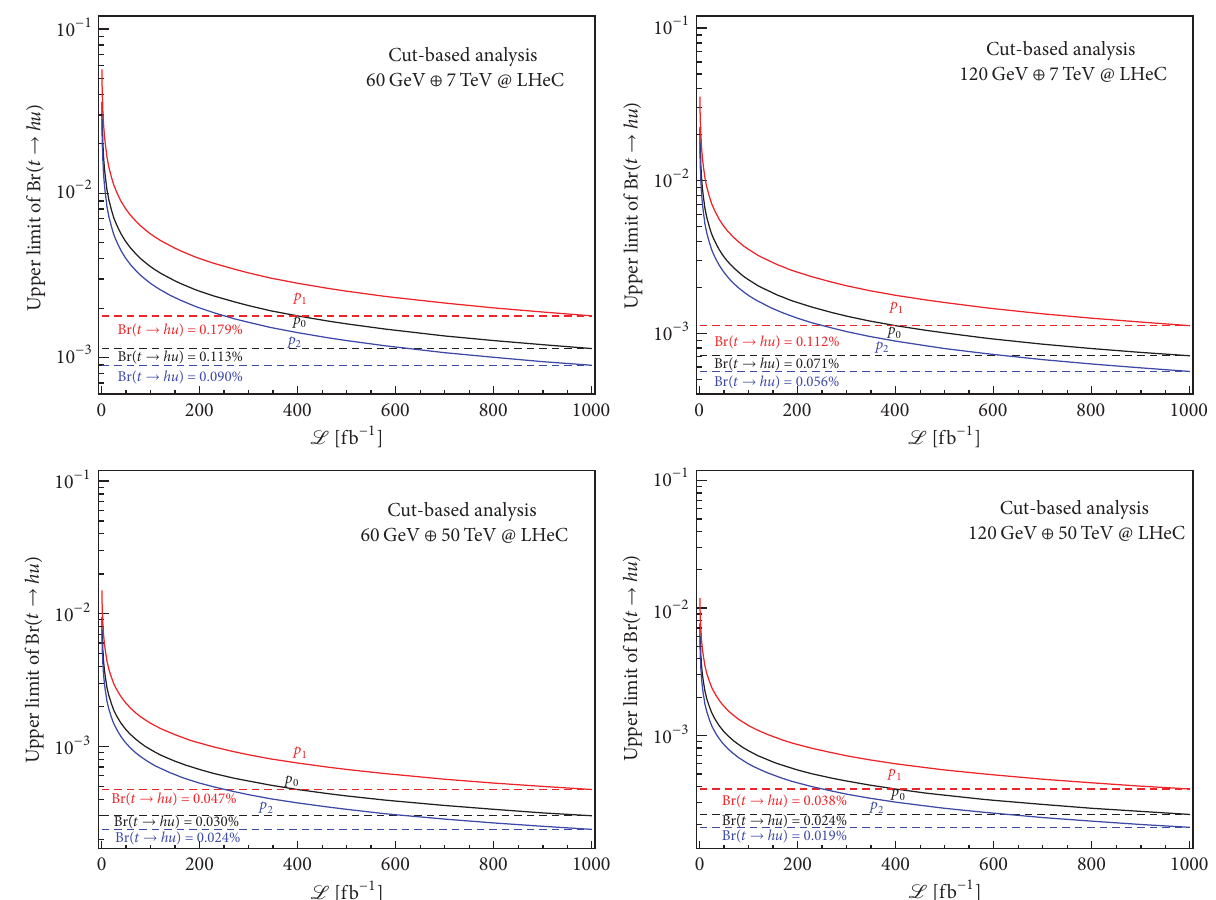
Figure 4: The upper limit from cut-based method at 1 𝜎 level at 7 (50)GeV LHeC with 60 (120)GeV electron beam. The red, blue, and black curves represent the 0.6, −0.6 , and without electron beam polarization.